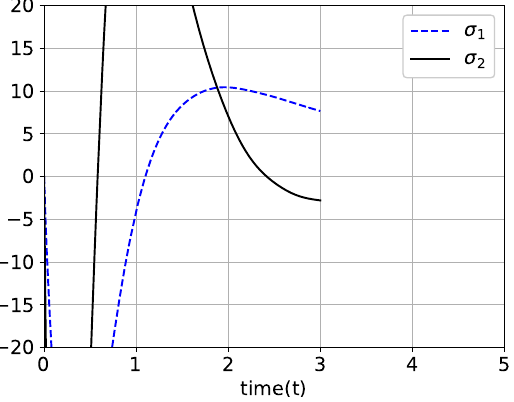
Figure 21. For HGO, trajectories of σ 1 and σ 2 .